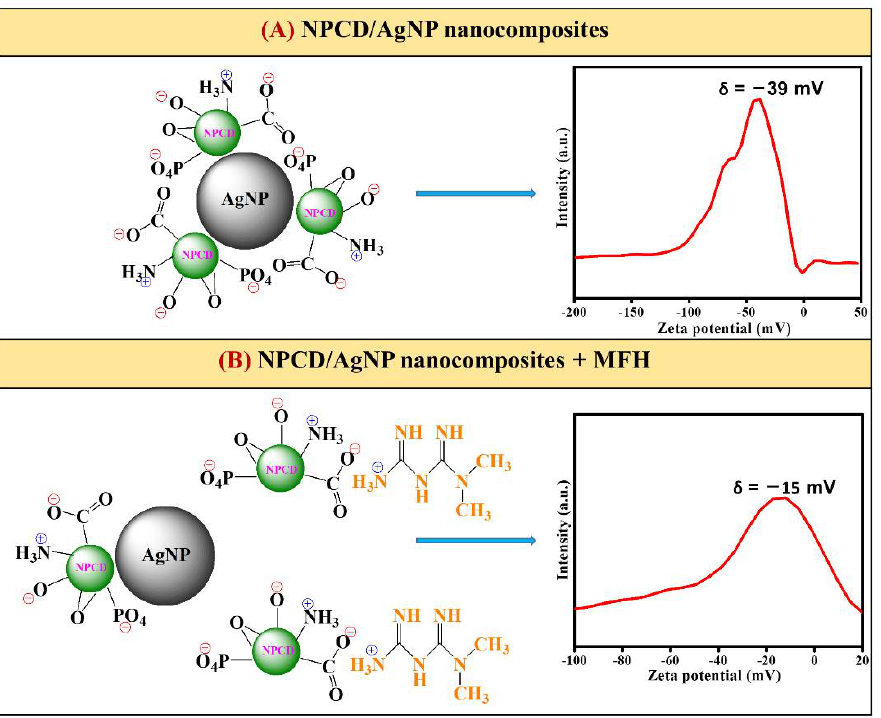
Figure 6. The basis of the zeta potential values of ( A ) the NPCD/AgNP nanocomposites and ( B ) the NPCD/AgNP nanocomposites + MFH (50 µg/L) solution.